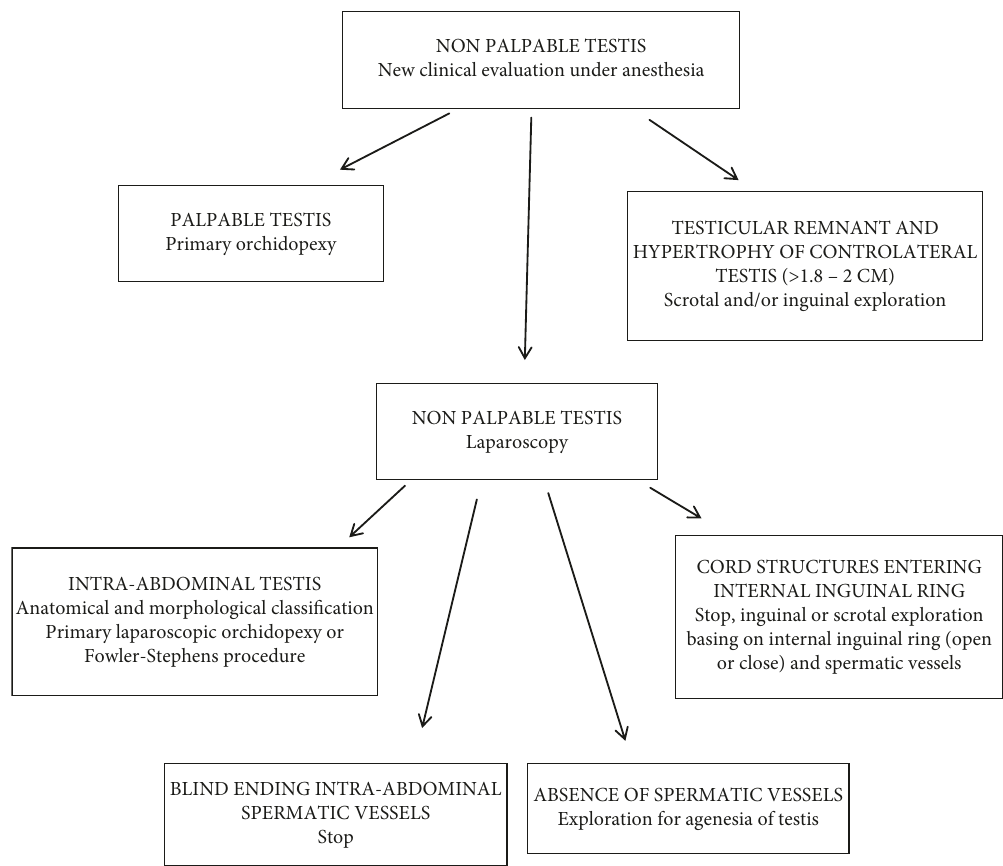
Figure 4: Flow chart showing the management of nonpalpable